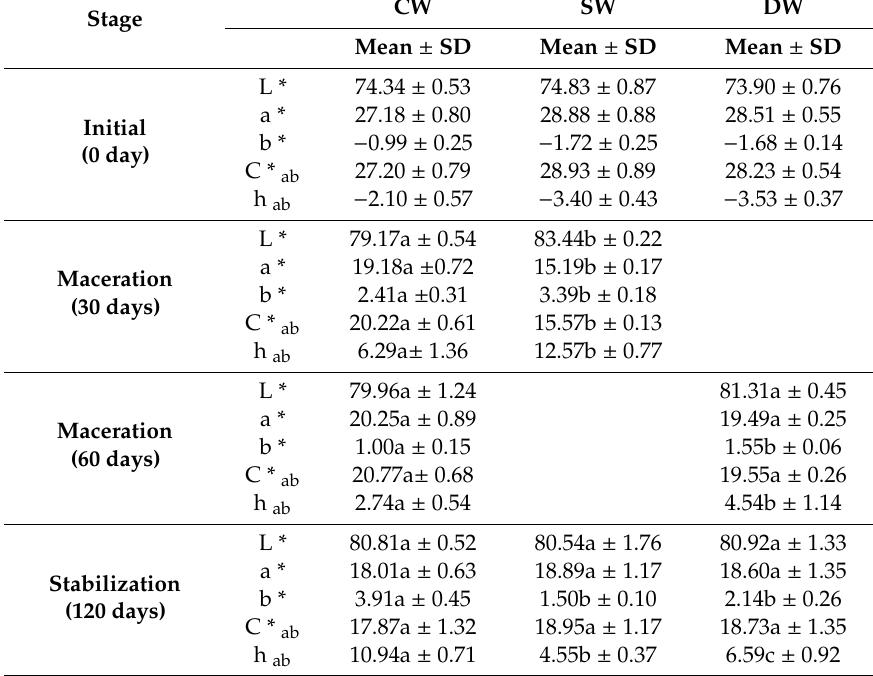
Table 2. CIELAB color parameters (L *, a *, b *, C * ab , and h ab ) for the di ff erent elaborated wines (CW, SW and DW) in three di ff erent stages of the winemaking process. For each parameter, di ff erent letters in the same row indicate statistical di ff erences (Tukey test, α =